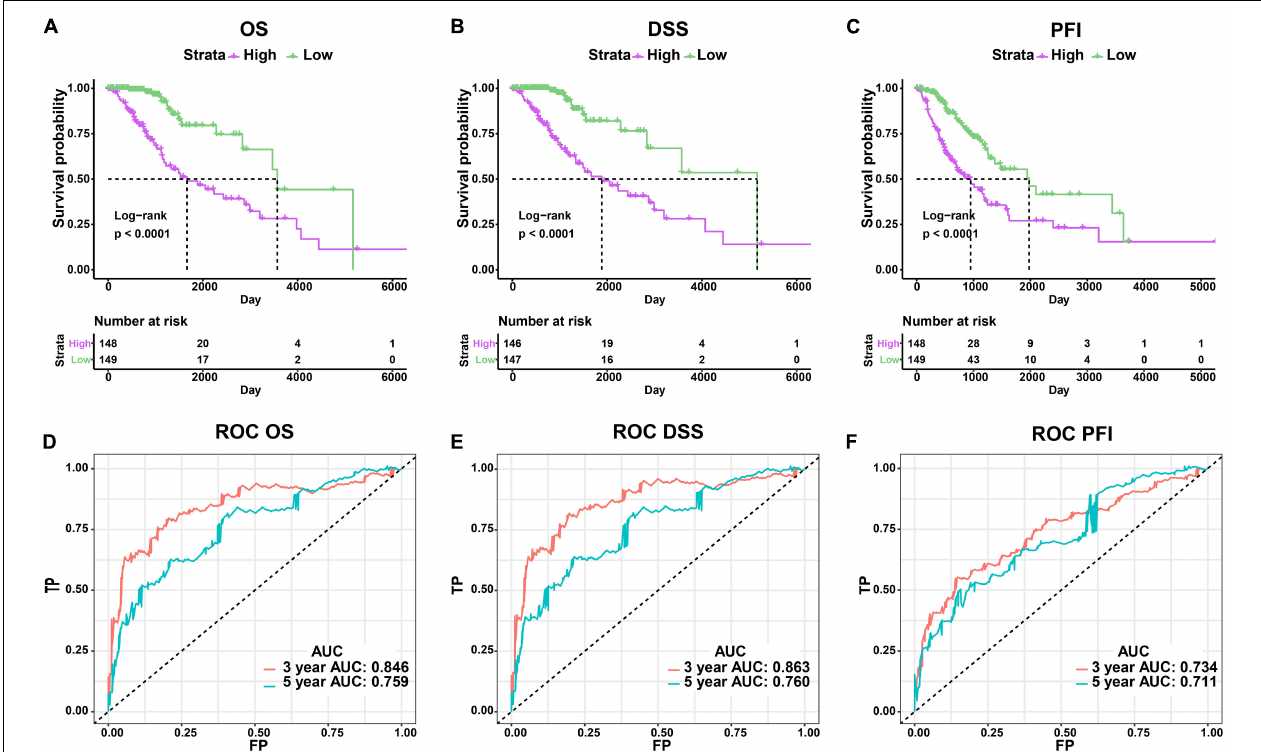
FIGURE 4 | Evaluation of the risk score model. (A–C) Comparison of clinical outcomes between high- and low-risk groups using OS, DSS, and PFI as the endpoints. (D–F) ROC curves and AUC values of risk model.